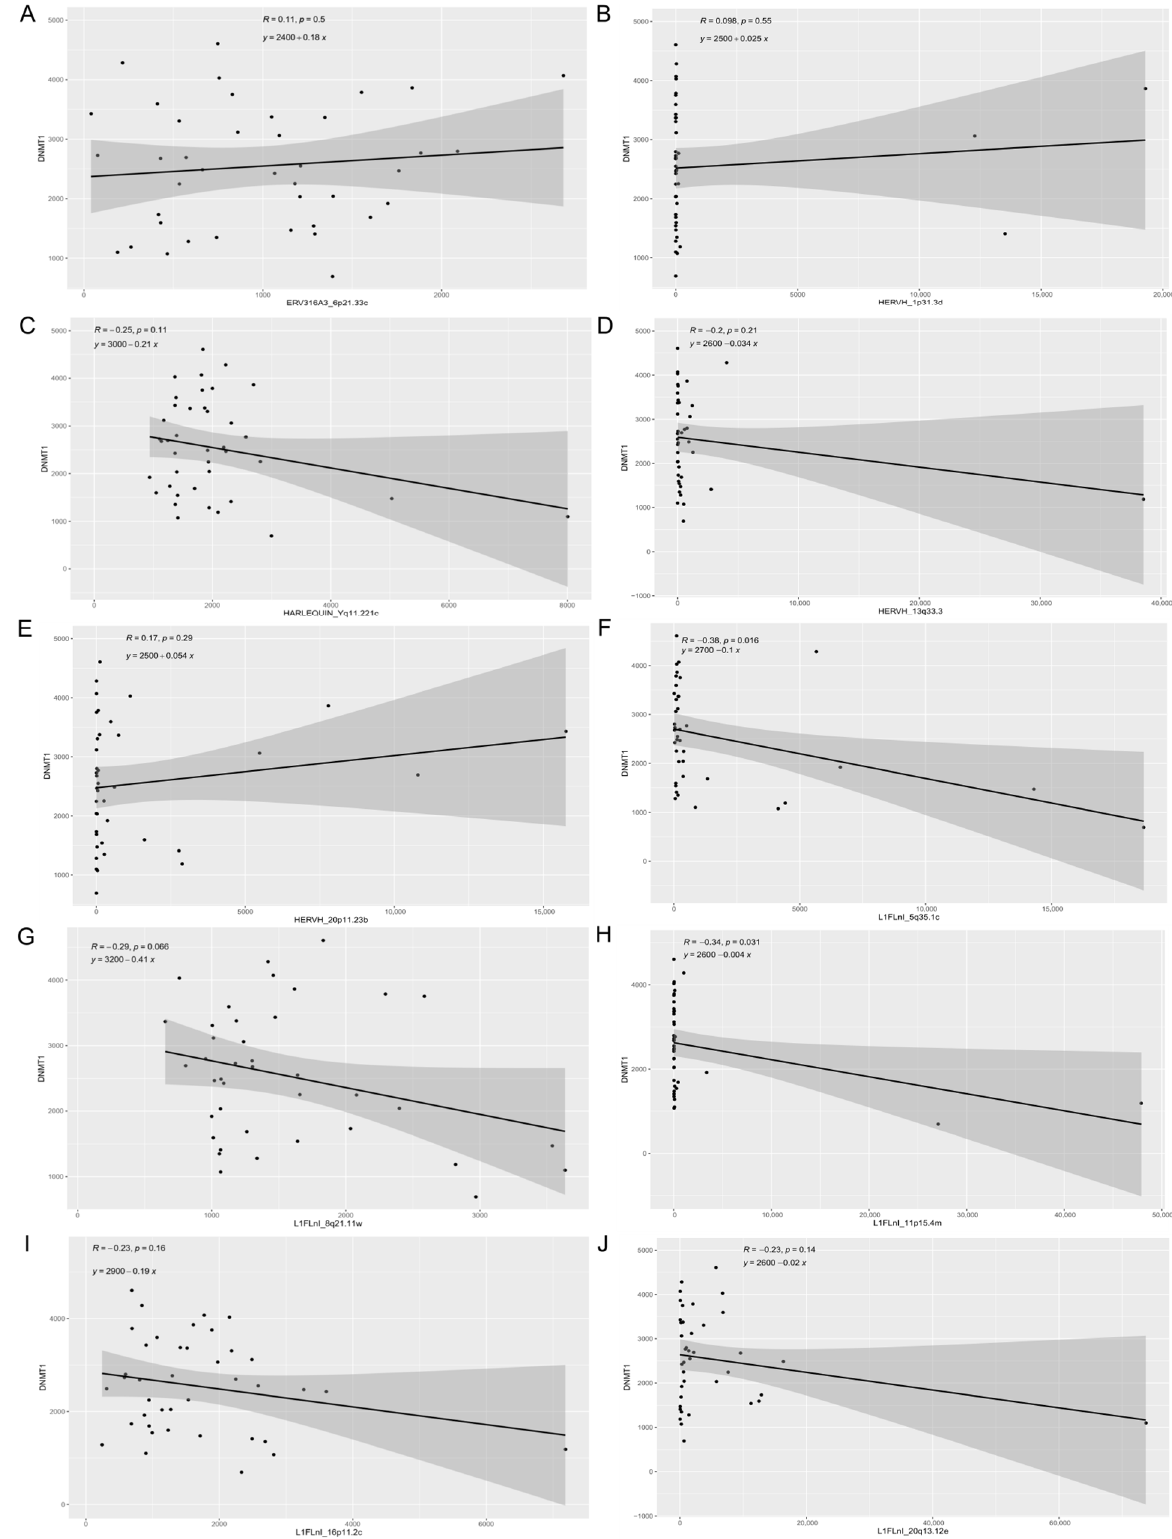
Figure 1. Correlation between DNA methyltransferase 1 ( DNMT1 ) and retroelement expression. Scatter plots show correlation of DNMT1 gene expression with ( A ) ERV316A3_6p21.33c , ( B ) HERVH_1p31.3d , ( C ) HARLEQUIN_Yq11.221c , ( D ) HERVH_13q33.3 , ( E ) HERVH_20p11.23b , ( F ) L1FLnI_5q35.1c , ( G ) L1FLnI_8q21.11w , ( H ) L1FLnI_11p15.4m , ( I ) L1FLnI_16p11.2c and ( J ) L1FLnI_20q13.12e . Pearson correlation coefficient (R), p -value (p) and linear equation are shown.